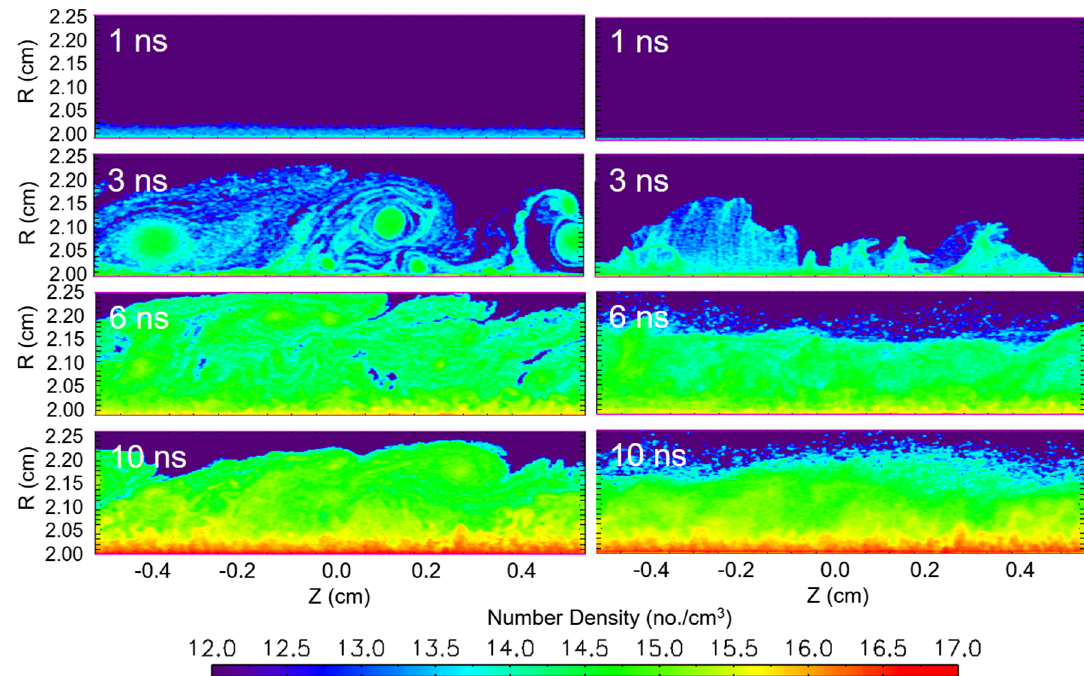
FIG. 4. In the MI transmission line simulation, the evolution of the electron density (left) and proton density (right) from 1 to 10 ns is plotted. The plasma evolves from the cathode (bottom electrode).